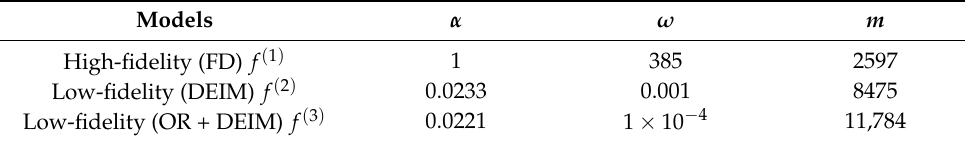
Table 5. Number of samples per model, coefficients and costs for Burgers’